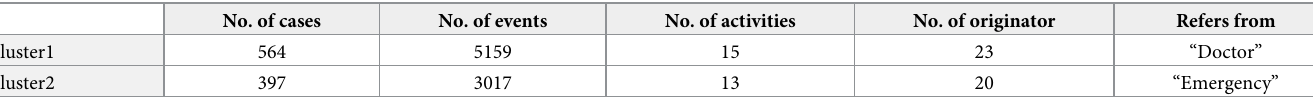
Table 3. The properties of the two clusters generated from using Markov clustering algorithm. No. of cases No. of events No. of activities No. of originator Refers